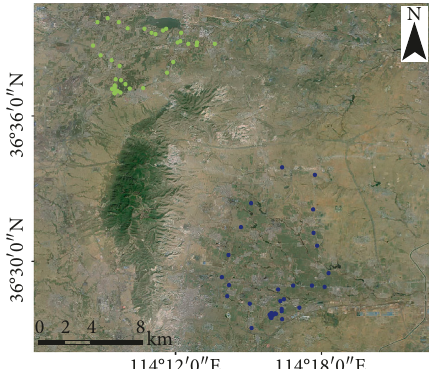
Figure 1: Study area and sampling sites. The upper left and lower right represent the WanNian and JiuLong experimental areas, respectively. The round dots indicate the sampling